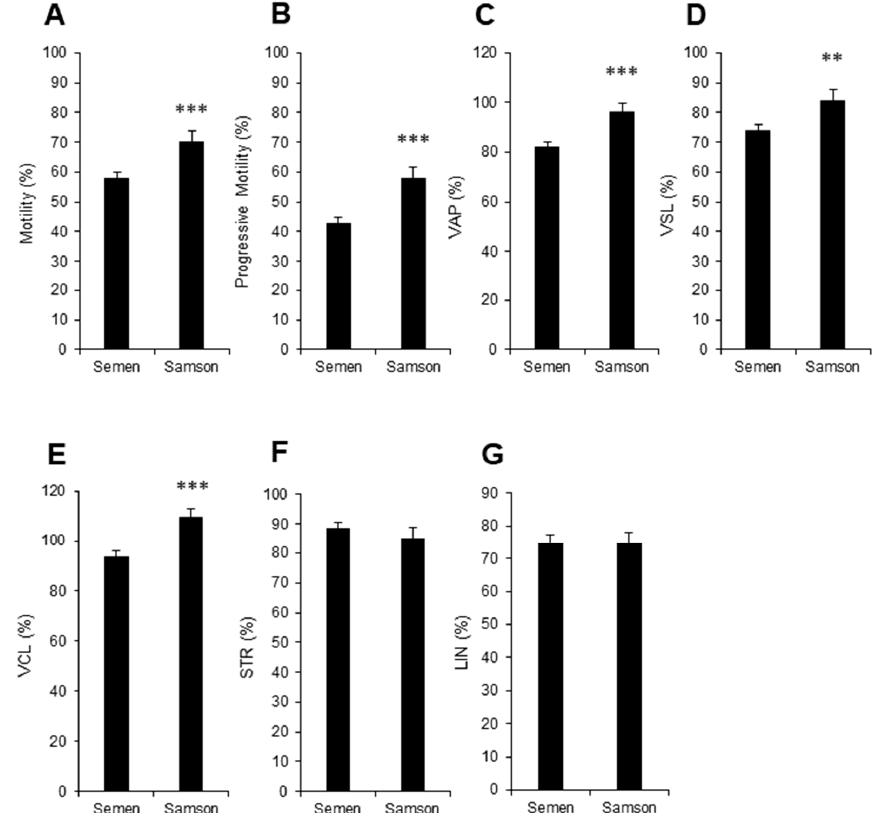
Figure 4. Isolation of stallion spermatozoa in a Samson™ chamber post-chilling. ( A ) Total motility, ( B ) progressive motility, and sperm velocity parameters ( C ) VAP, ( D ) VSL, ( E ) VCL, ( F ) STR, and ( G ) LIN values of isolated samples (Samson) were compared with motility parameters from the parent population (Semen; ** p < 0.01; *** p < 0.001).